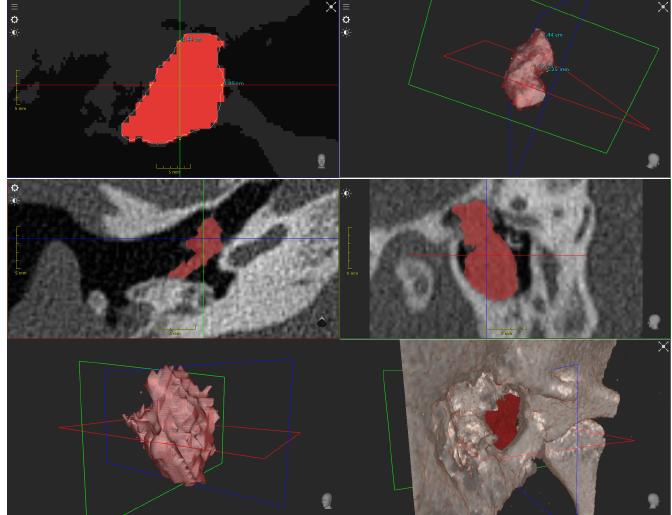
Figure 14. The preoperative CT segmentation from Patient #1 ( Top row ) and Patient #2 ( Middle and Bottom rows ) give a first good indicator about the size, shape, and volume of the